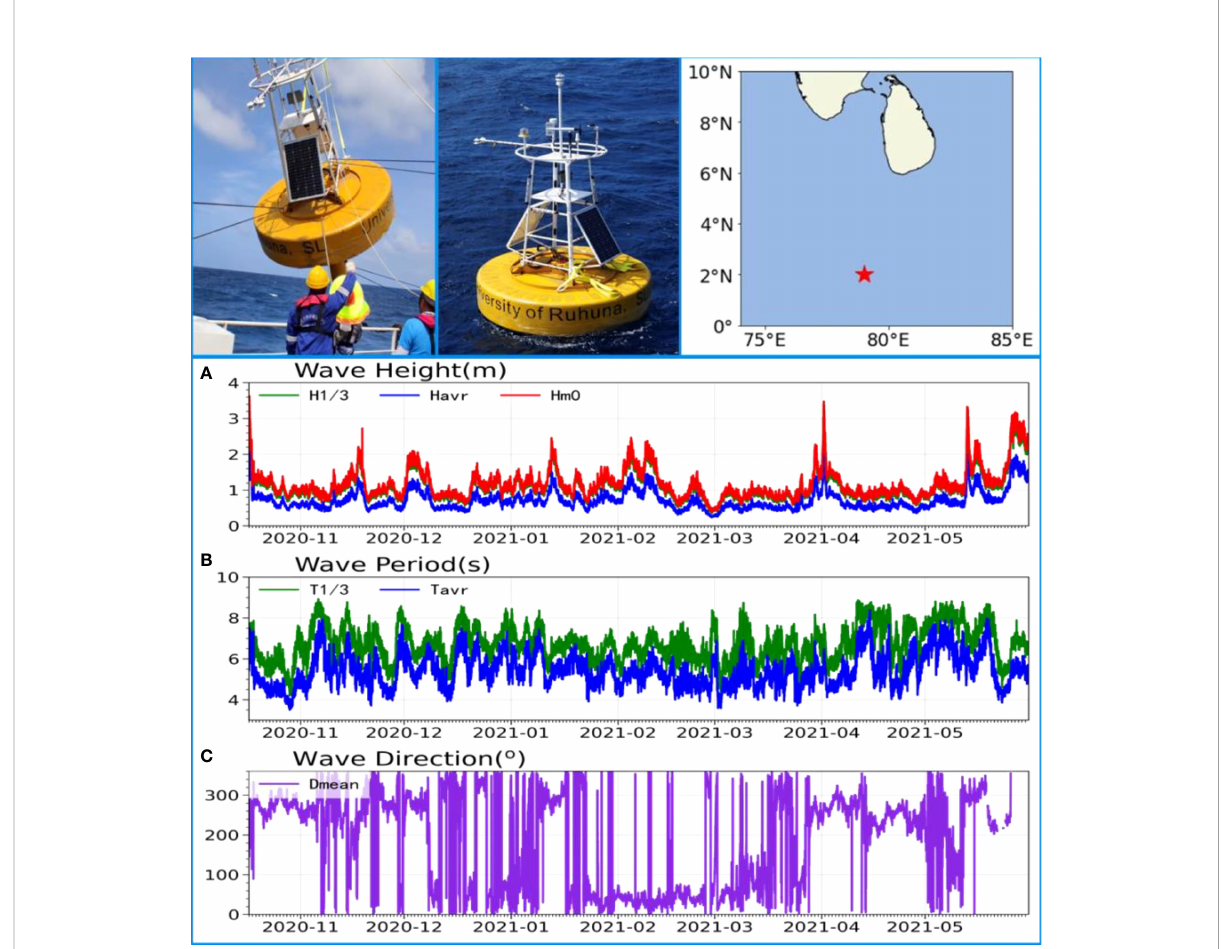
FIGURE 13 Wave observation in the Equatorial Indian